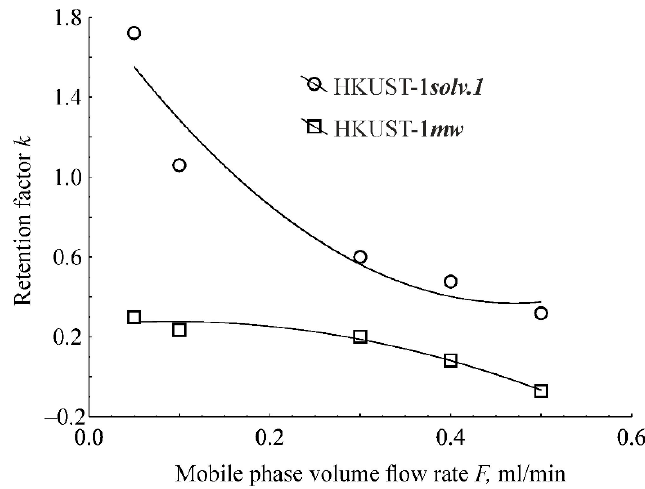
Figure 7. Dependences of the benzene retention factor on the volumetric flow rate of the mobile phase for the HKUST-1 mw and HKUST-1 solv.1 samples.